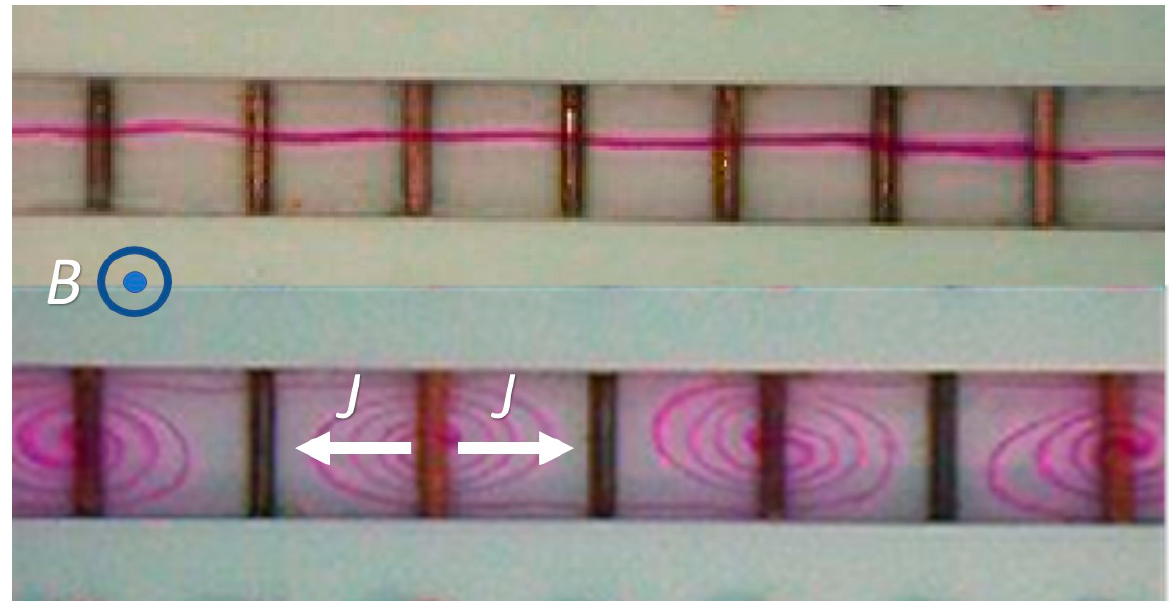
Figure 4. A conduit equipped with transverse electrodes, filled with electrolyte solution, and sub- jected to a uniform magnetic field. The figure illustrates the deformation of an initially straight line of dye [38] ( Top ) placed at the conduit’s mid-height in the absence of potential differences among the electrodes. ( Bottom ) Potential differences applied to the vertical electrodes induce electrical currents ( J ) with opposite directions that, in the presence of the magnetic field, result in Lorenz forces in opposing directions and in flow circulation, as is evident from the deformation of the dyed line.